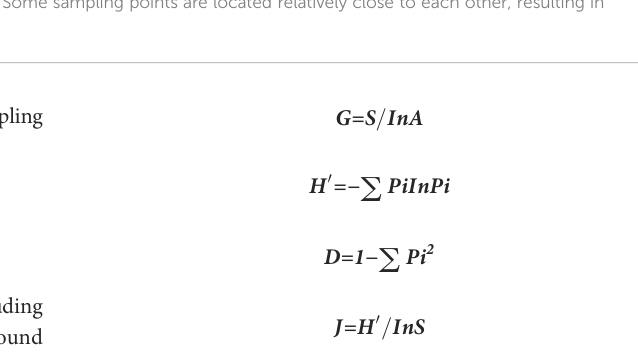
FIGURE 1 The distribution of vegetation types and sampling sites on the Three-River Headwaters Region. The vegetation map is based on a 1:1,000,000 scale vegetation distribution map of China (http://westdc.westgis.ac.cn). EG, E.nutans -dominated grassland; PM, P.anserina -dominated meadow; AM,